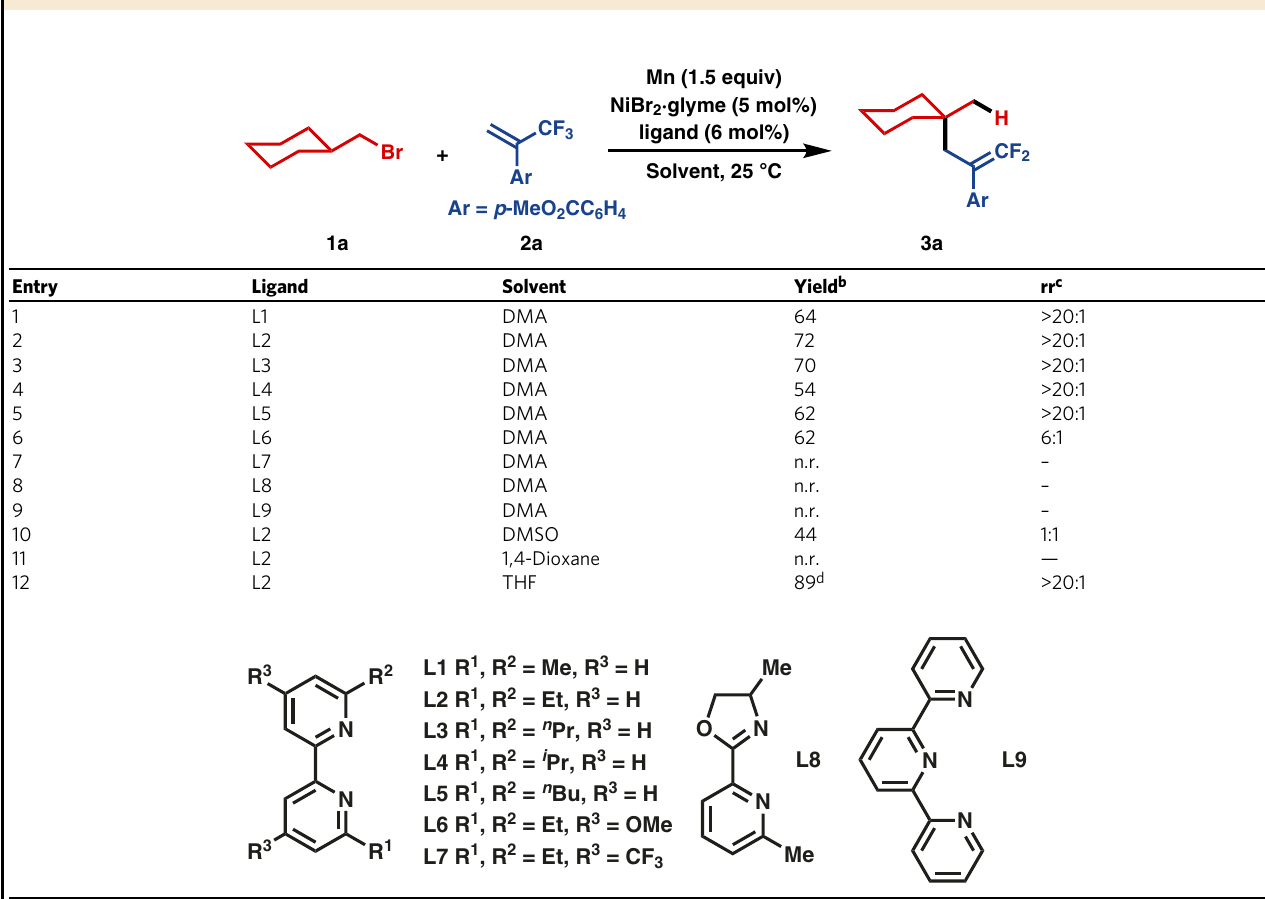
Table 1 Optimization of the reaction conditions a